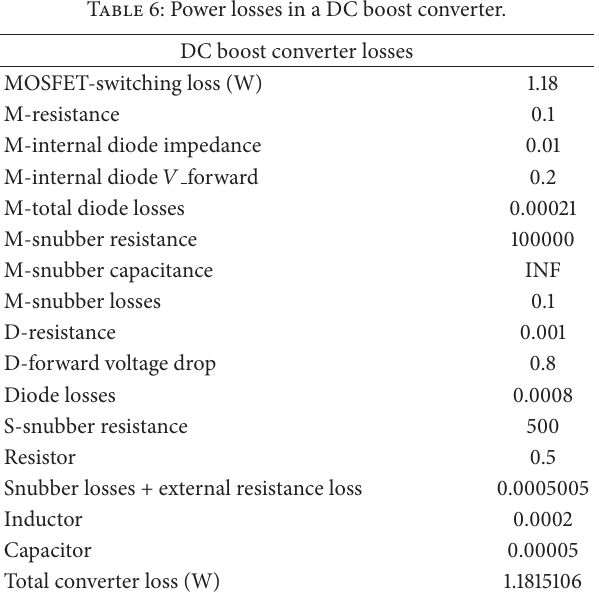
Table 6: Power losses in a DC boost